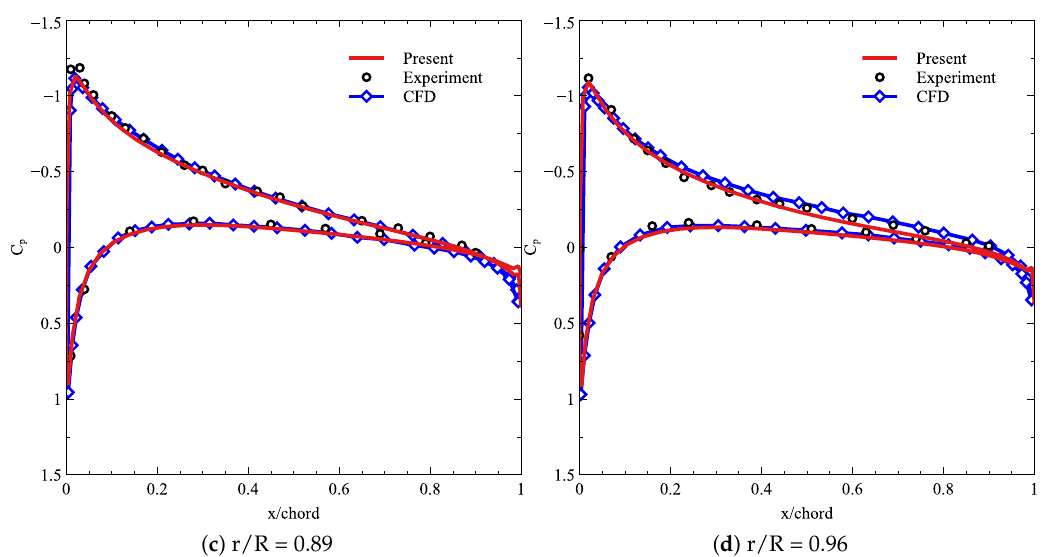
Figure 9. Pressure coefficients at a collective pitch angle of 8 ◦ .